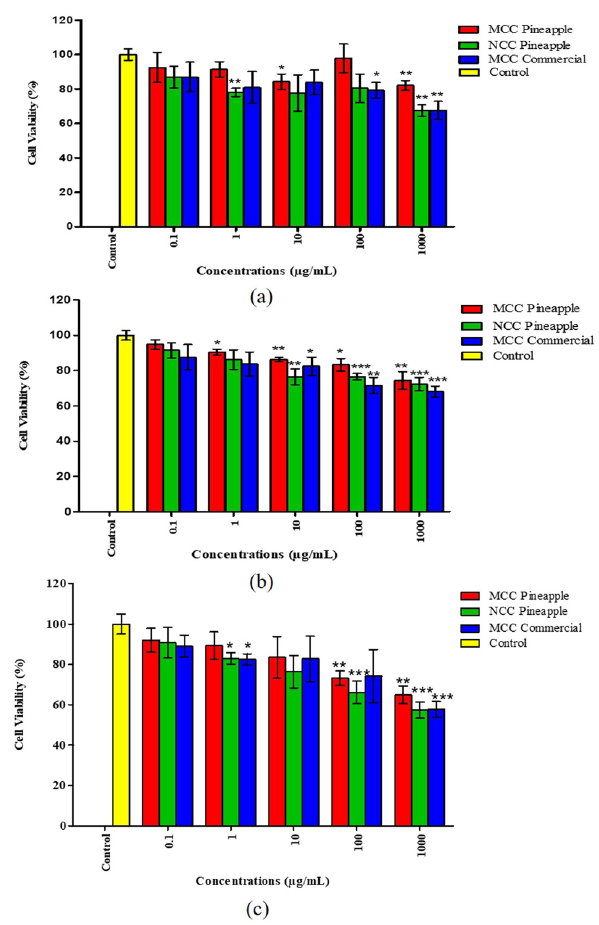
Figure 9: Cytotoxicity e ff ect of MCC, NCC, and commercial MCC against human normal lung cells ( MRC - 5 ) for 24, 48, and 72 h of treatment. The analysis was performed using GraphPad Prism 5.0 and t - test analysis was done for each group. The * symbol indicates the signi fi cance level of the treatment, where *, **, and *** are p < 0.05, p < 0.01 and p < 0.001, respectively for treatments compared with the control of each